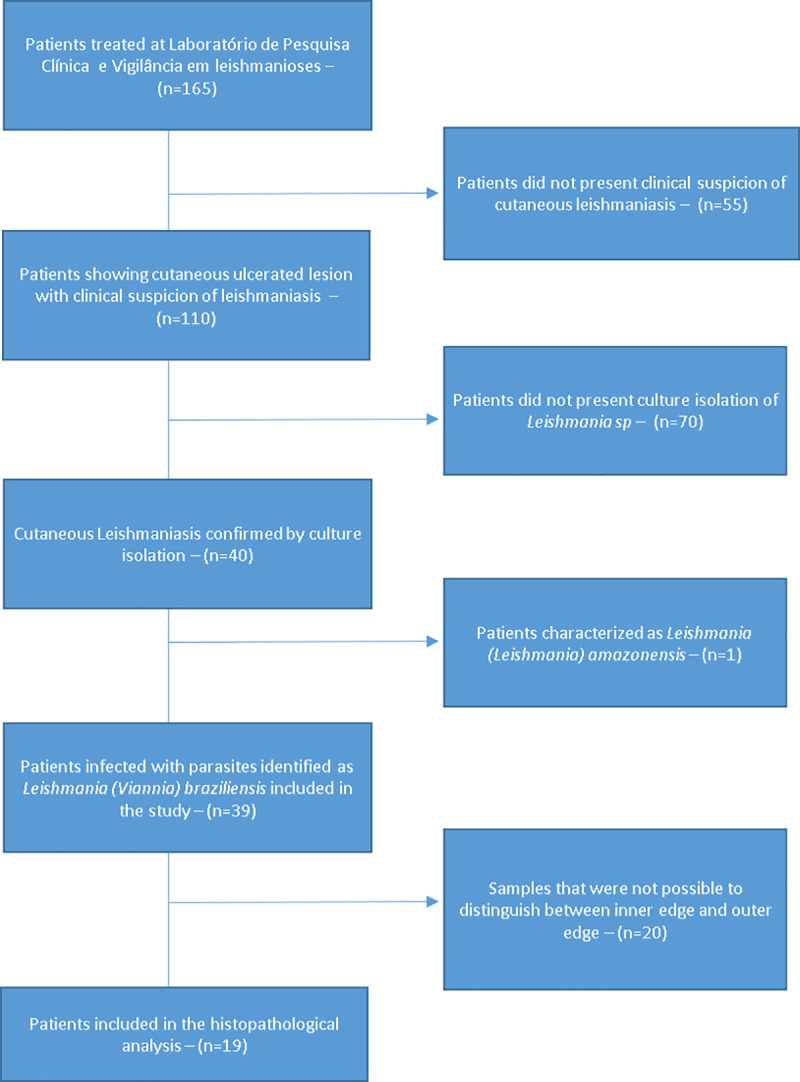
Flowchart of inclusion / exclusion of patients evaluated in the study, Rio de Janeiro, Brazil, 2009–2010.*16 cases had well characterized ulcers, 9 cases pseudoepitheliomatous squamous hyperplasia, 17 cases granulation tissue and 8 cases necrosis.